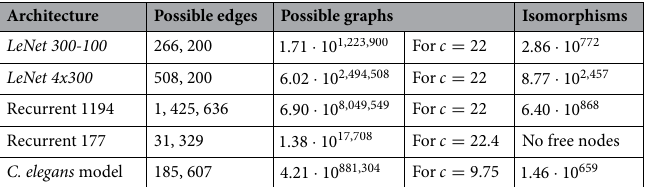
Fig. 6d. Per definition, the connectome-based recurrent networks can not have isomorph graphs, because these networks have no free nodes that are not connected to an input or output. The isomorphism test checks only the possibility of an isomorphism in general. It cannot test against the specific conditions of fixed input and output nodes. So the algorithm tends to show a higher possibility that an isomprophism exists than actually would be the case. A discussion of the absolute changes in the graphs requires a reference in order to be able to estimate how large a change actually is. For this purpose different theoretical values of the graphs were calculated. The number of possible edges